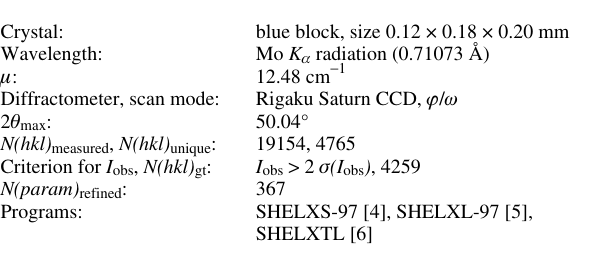
Table 1. Data collection and handling.